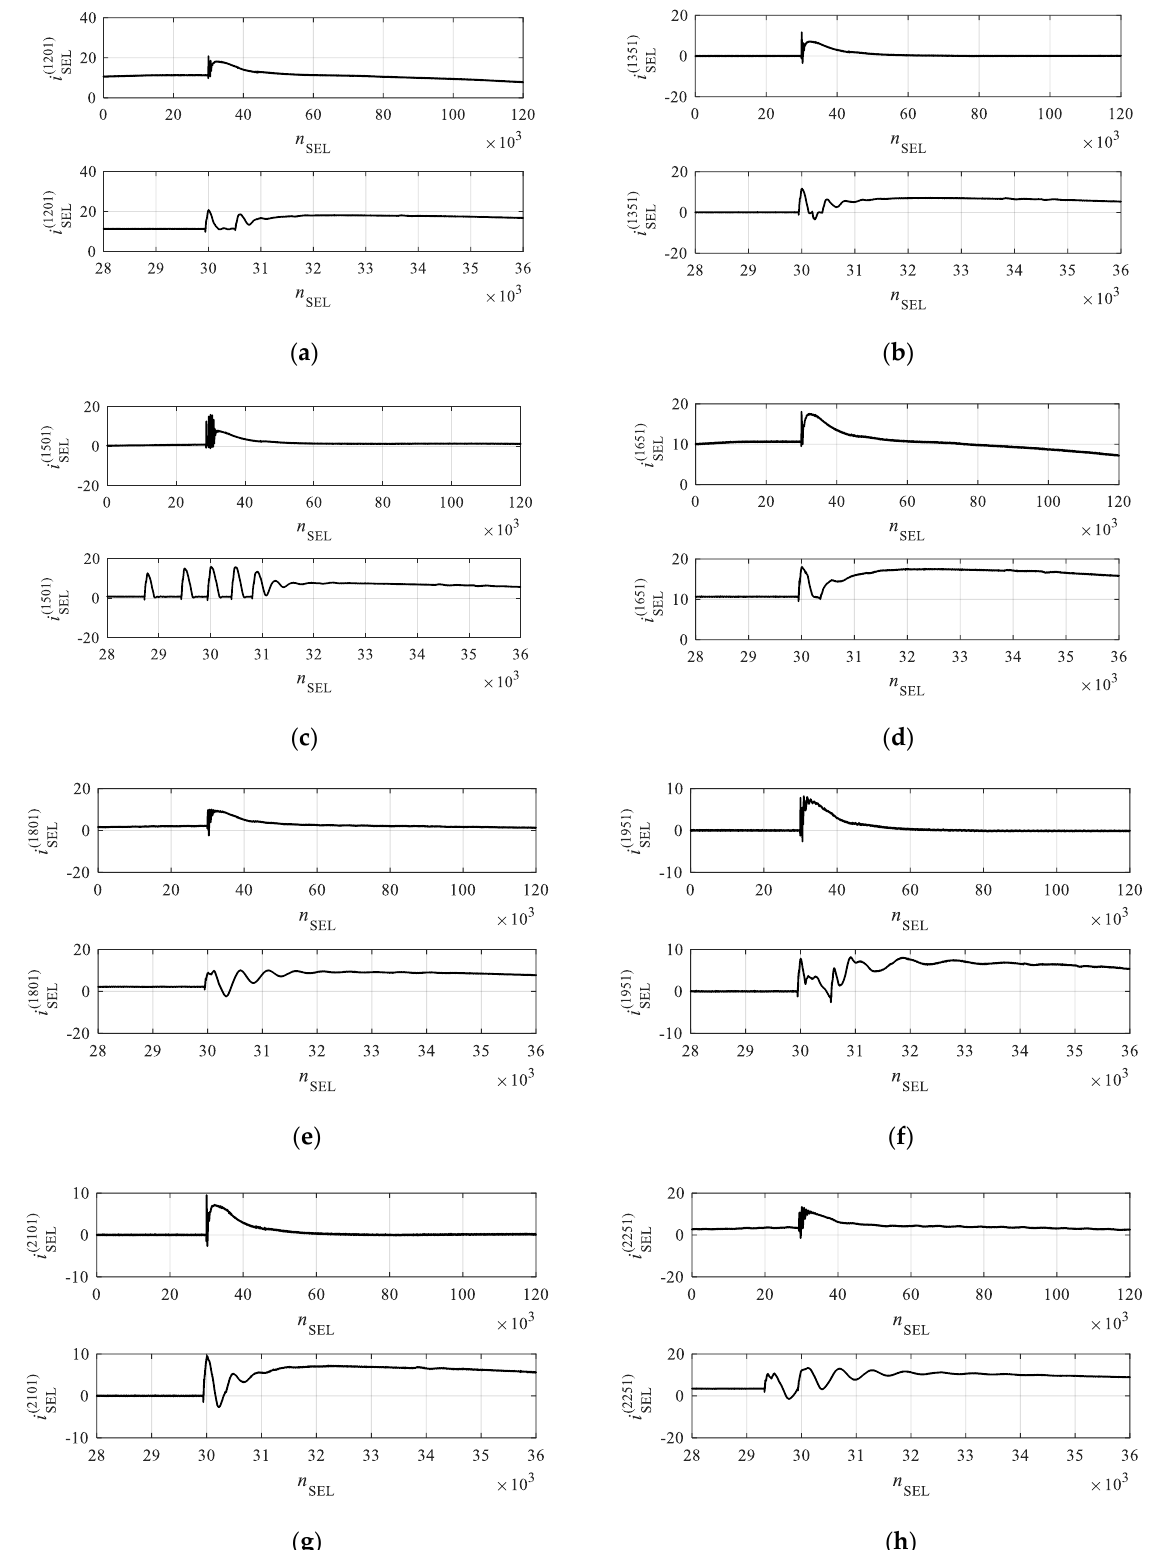
l i for selected examples l belonging to categories 8 – 15. = 1201 l : iron ( a ), = 1351 l : ( l ) Figure 19. Current vector ( ) Figure 19. Current vector i for selected examples l belonging to categories 8–15. l = 1201: iron ( a ), l = 1351: sharpener S EL SEL ( b ), l = 1501: grinder ( c ), l = 1651: kettle ( d ), l = 1801: jigsaw ( e ), l = 1951: coffee machine ( f ), l = 2101: air conditioner sharpener ( b ), ( g ), l = 2251: planer ( h air conditioner ( g ), = 2251 l : planer ( h ).